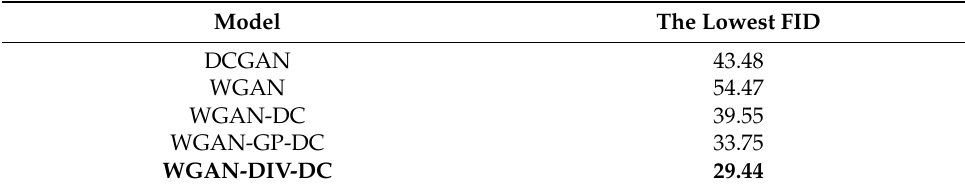
Figure 9. Comparison FID values of different GAN models. Table 1. FID score comparisons for different GAN models. The bold indicates the best model with the best performance.